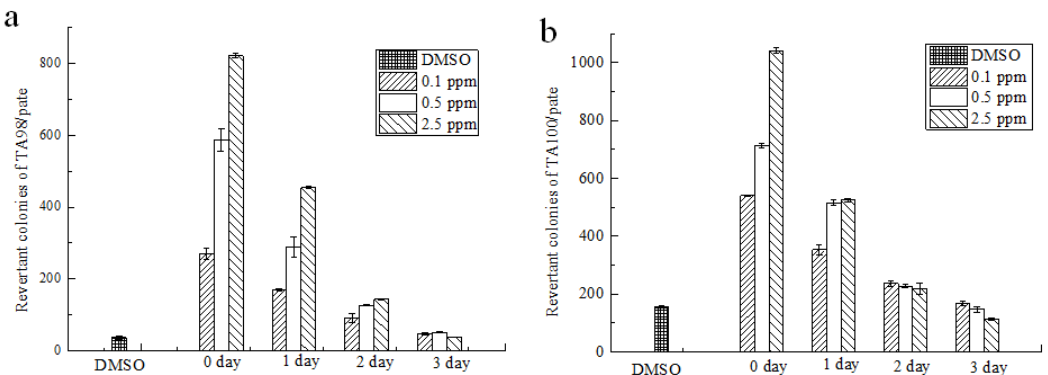
Figure 5. Test results of mutagenicity of AFB 1 degradation products ( − S9), Note: Figure ( a , b ) were mutagenicity of the degradation products of strains TA98 and TA100 after degradation for